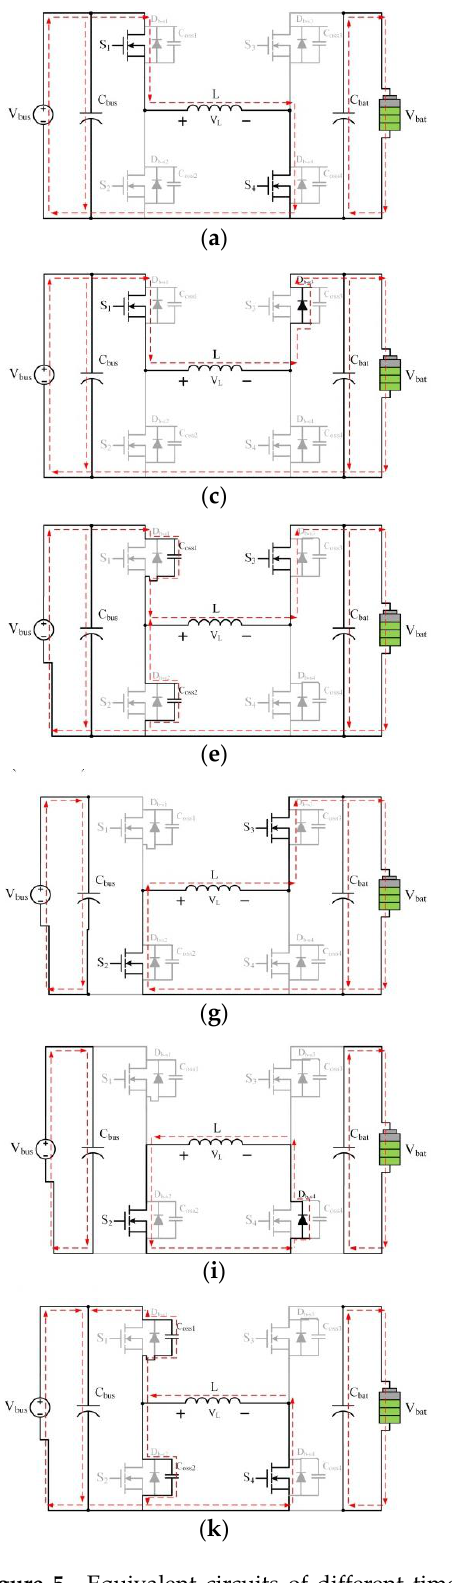
Figure 5. Equivalent circuits of different time intervals for buck-charging mode. ( a ) Interval 1; ( b ) Interval 2; ( c ) Interval 3; ( d ) Interval 4; ( e ) Interval 5; ( f ) Interval 6; ( g ) Interval 7; ( h ) Interval 8; ( i ) Interval 9; ( j ) Interval 10; ( k ) Interval 11; ( l ) Interval 12.